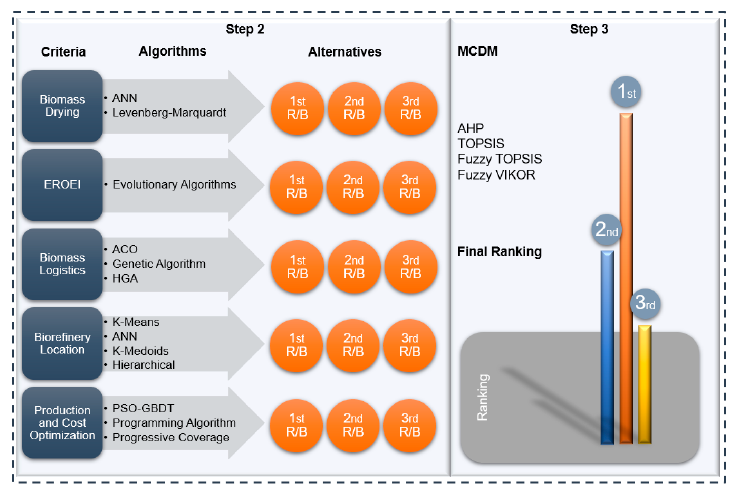
Figure 4. Detailed illustration of steps 2 and 3 in Phase 2.